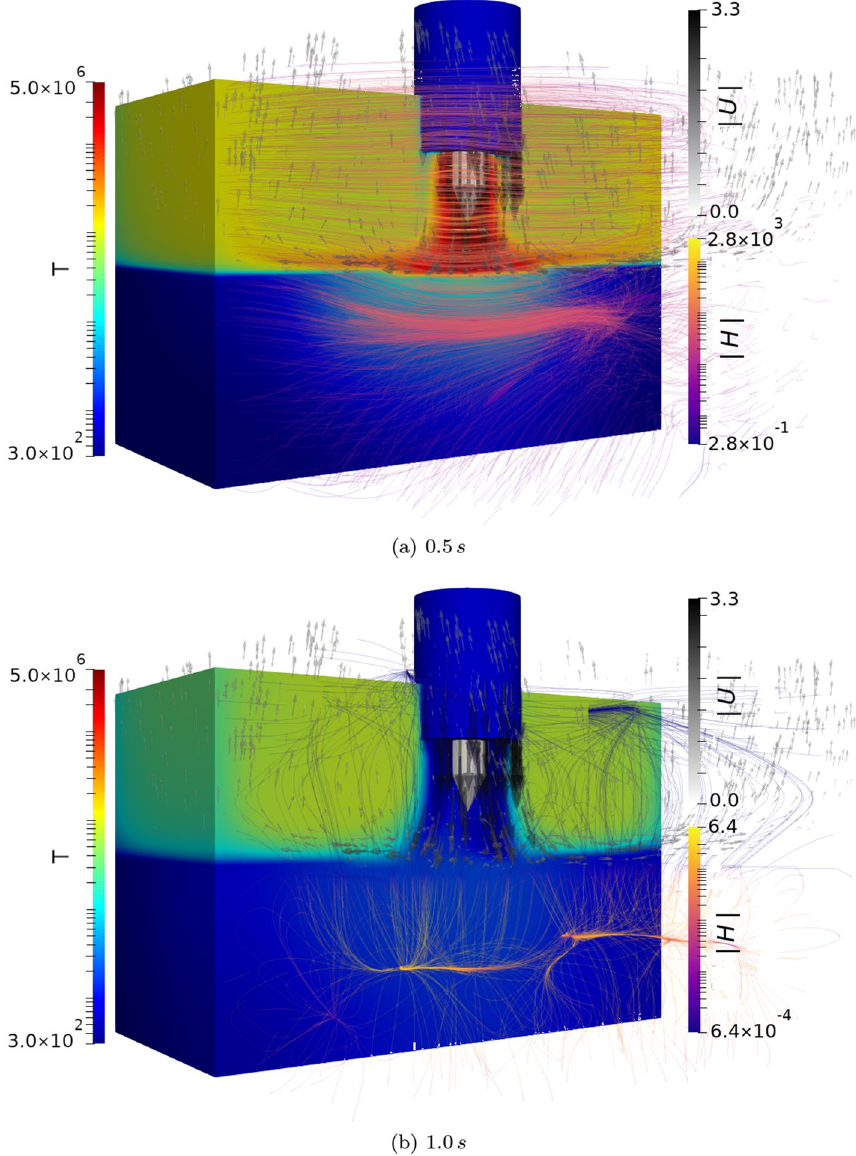
Figure 6. Evolution of the U , H and T fields inside the computational domain. The magnitude of the H field, − 1 − 1 initially set to 5.3 × 10 3 A m is set to 0 A m at t = 0.52 s. As the current density rapidly decreases after this time, so does the Ohmic heating effect, and therefore the temperature in the vicinity of the weld-pool decreases. Here U glyphs are plotted, along with stream lines for the H